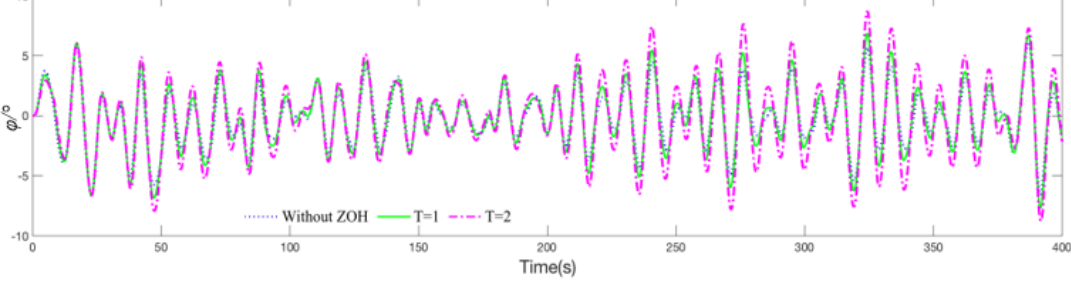
Figure 13. Roll angle of ship.